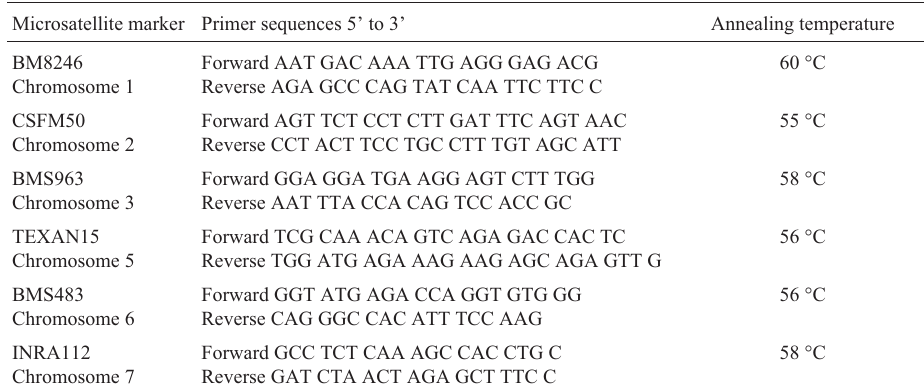
Table I - Description of six microsatellite primers and their respective annealing